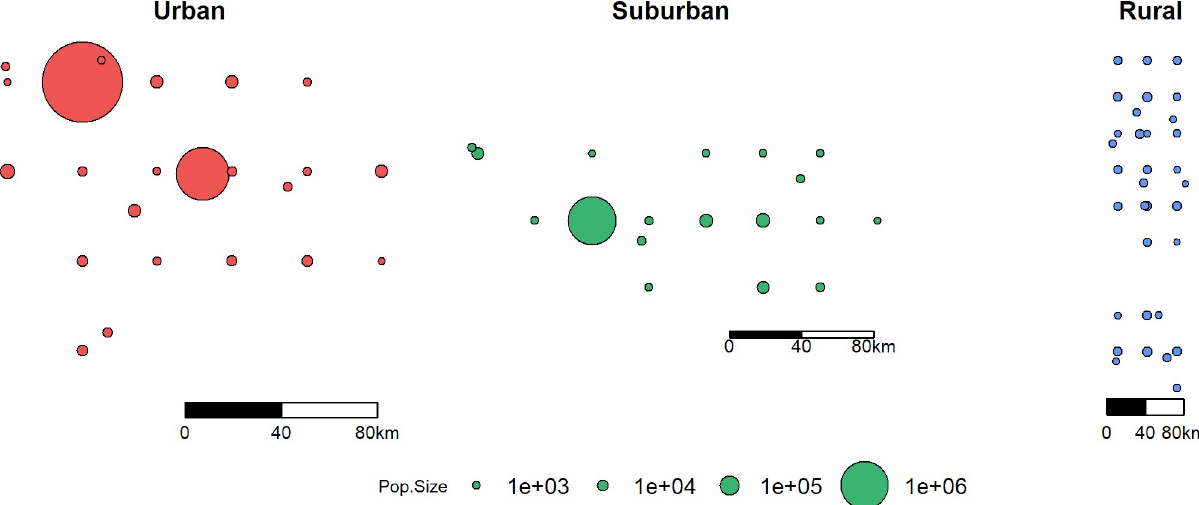
Fig 4. Simulated regions with different population densities and spatial